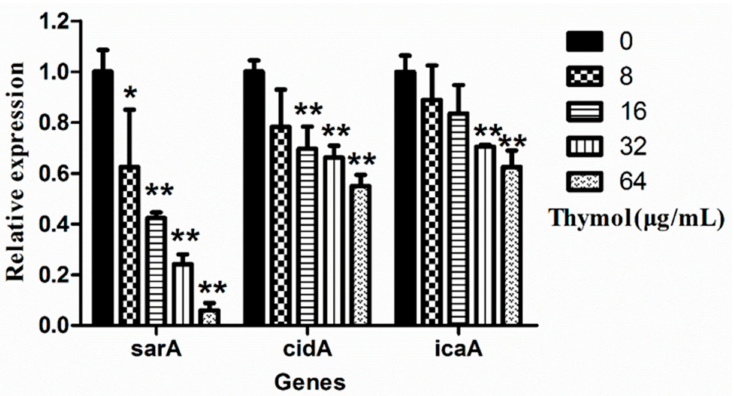
Figure 6. Expression of ica A, cid A and sar A in TCH1516 in the presence of various concentrations of thymol. ** p < 0.01 or * p < 0.05, compared with the same genes in the 0 µ g / mL group.